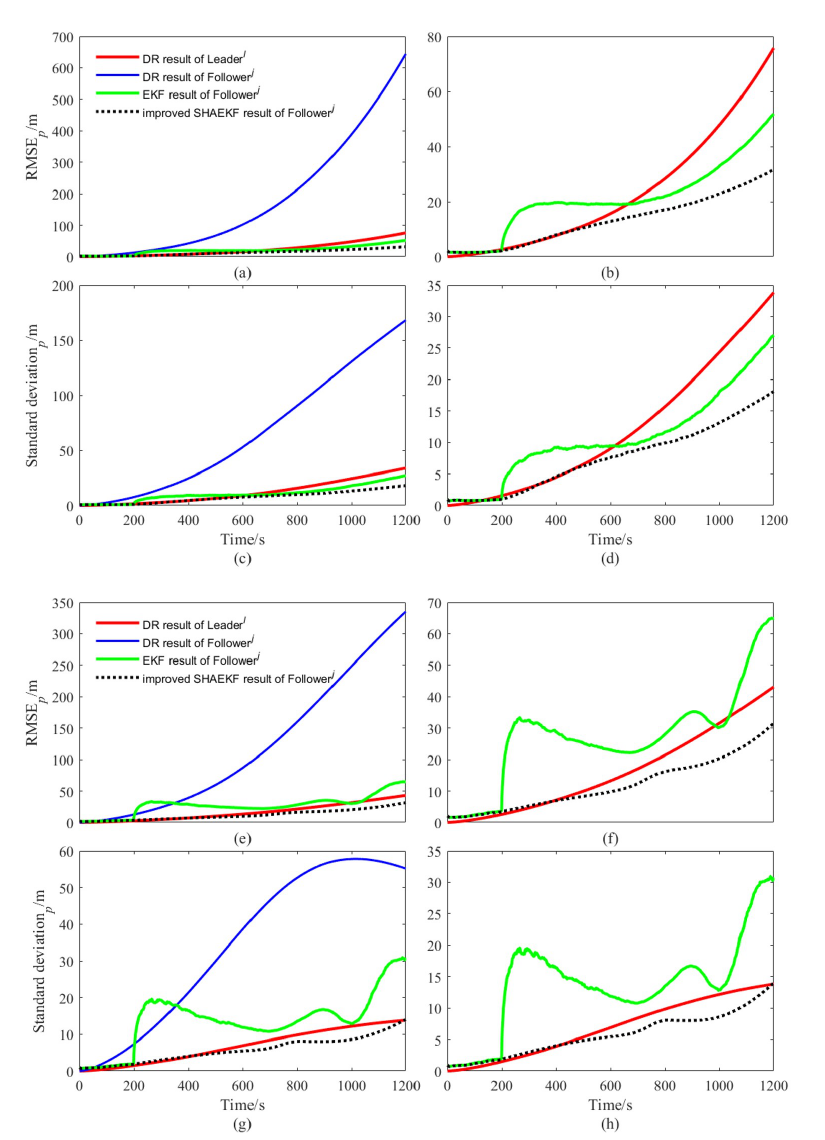
Figure 8. Comparison diagram of localization errors in case of measurement abnormality. ( a – d ) Description of the results of AUVs that moved along a straight line at a uniform constant speed; ( e – h ) description of the results of AUVs that moved along a curve at a uniform constant speed; ( a , b , e , f ) description of the change in the root mean square of localization errors with time for each algorithm; ( c , d , g , h ) description of the variation of the standard deviation of localization errors with time for each